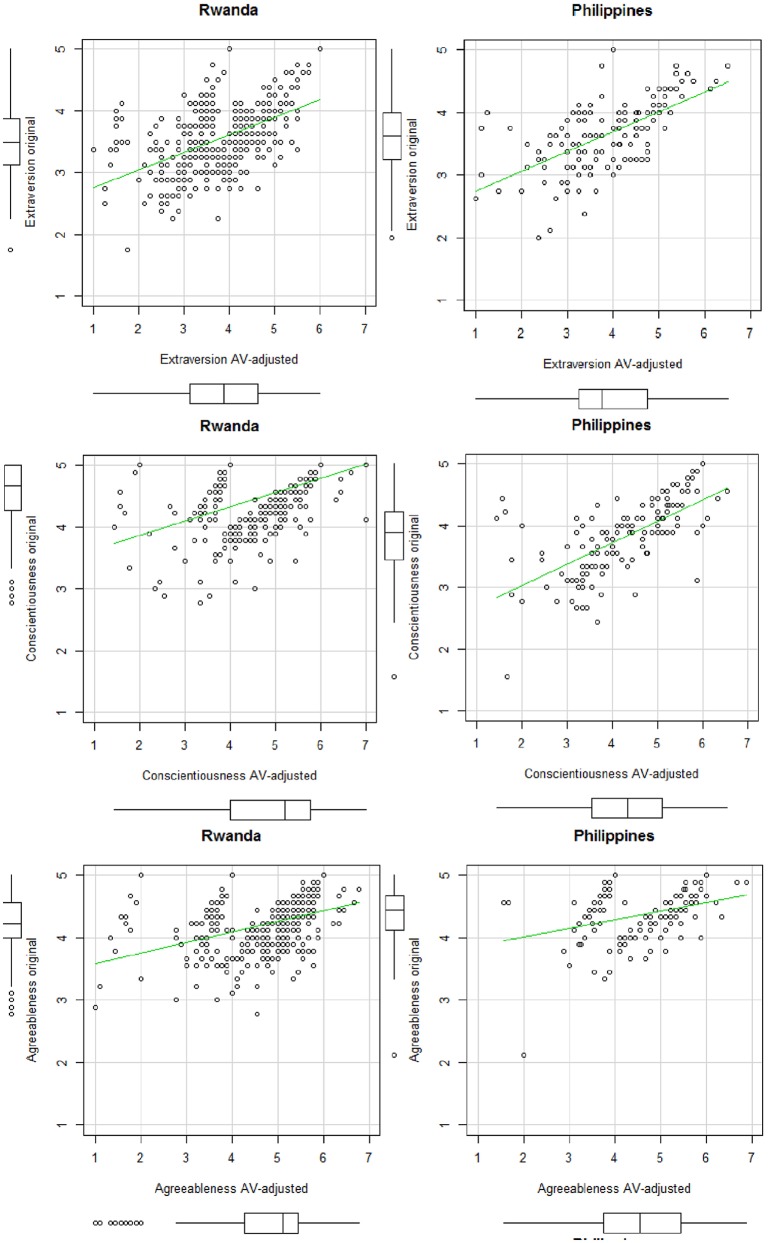
Scatterplots of the original and the AV-adjusted scales for Rwanda (N = 423) and the Philippines (N = 143).